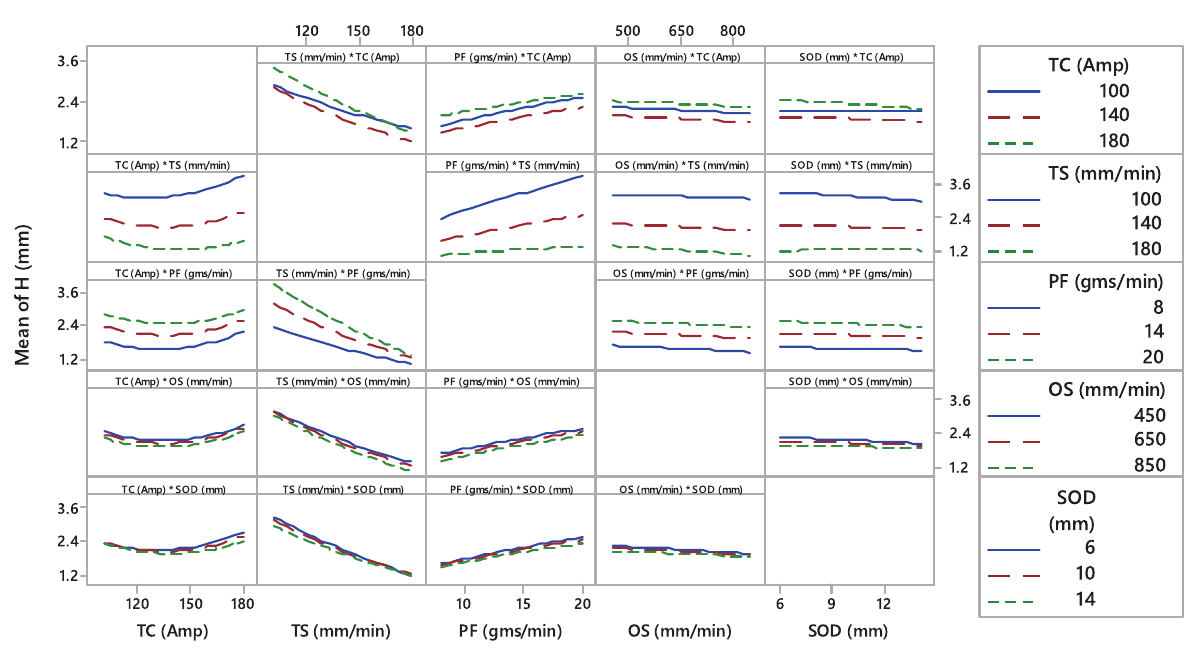
Figure 5: Interaction plots for